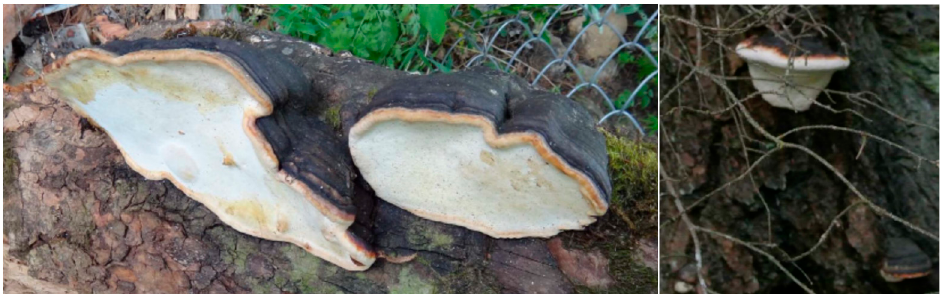
Figure 1. Basidomes of Fomitopsis pinicola in situ. These specimens were identified as F. pinicola by internal spacer region 2 sequencing [13]. (Permission was obtained from NZFocus to utilise this image.) In 2016, Haight et al. reported on an investigation into the suspected F. pinicola complex [14]. Based on samples collected in North America, Europe and Asia and phenotypically identified as F. pinicola , four distinct species were identified, with only F. pinicola found in Europe and Asia. The other three species were found in different regions of North America [1,14]. For this reason, articles based on samples collected outside of Europe and Asia were not included in this review article.